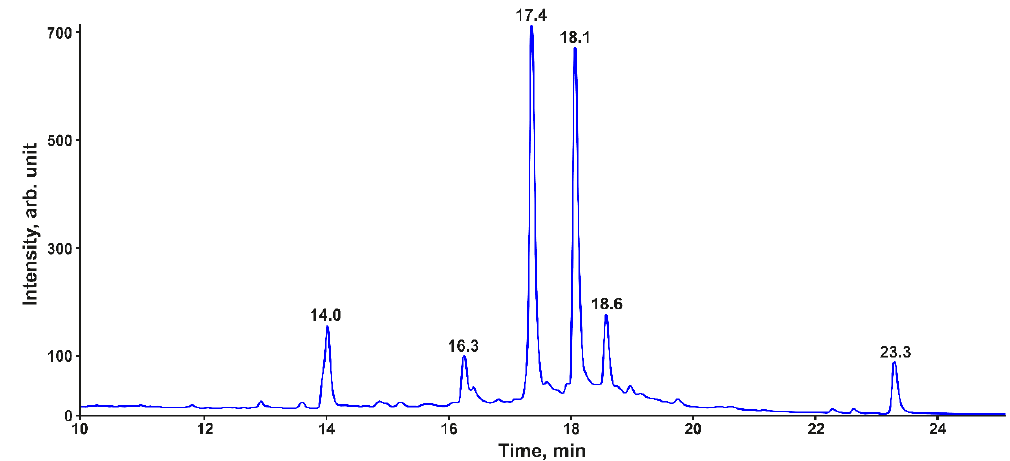
Figure 2. HPLC-UV (280 nm) chromatogram of acetone extract of P. commune .